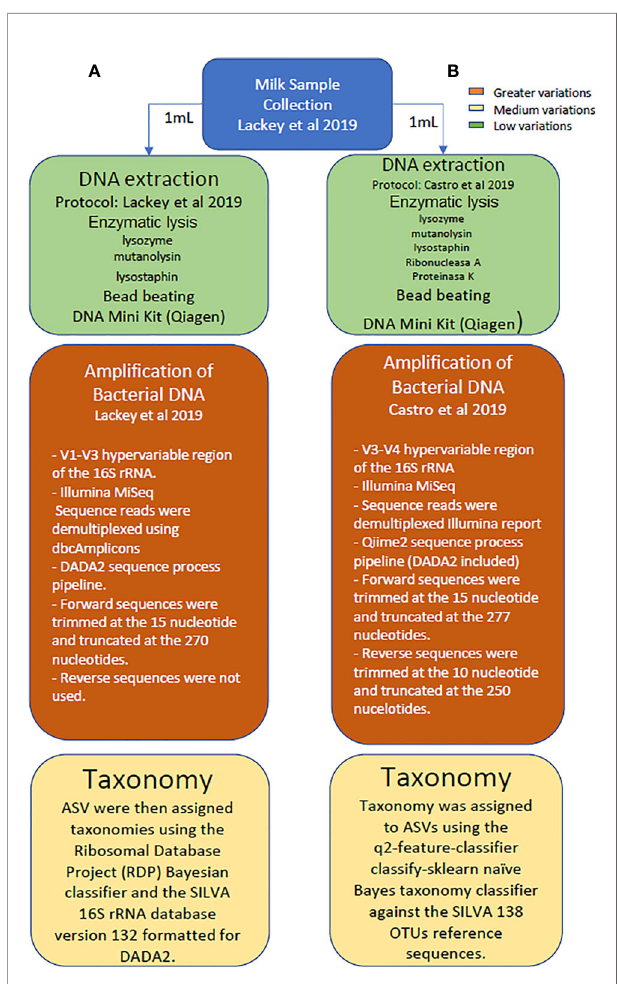
FIGURE 1 | Schematic representation highlighting the main differences in the methodological and analytical strategies followed in the study reported by Lackey and colleagues, as compared to the sequencing approach conducted herein with the same dataset of